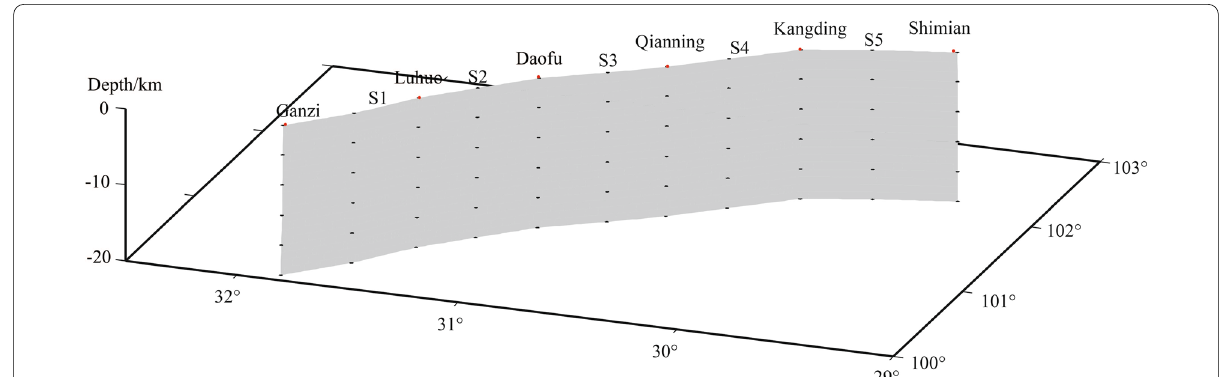
Fig. 4 Three-dimensional fault structure and node setting of the Xianshuihe Fault Zone